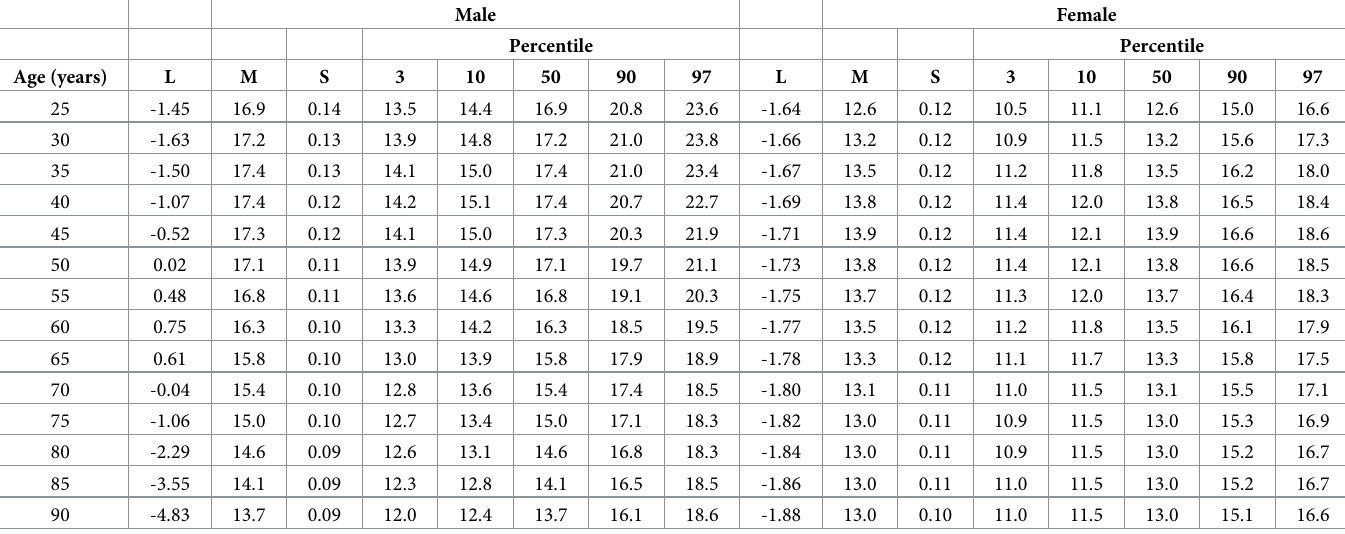
Table 3. Sex-specific percentile values for lean mass index (LMI) in individuals aged 21–90 years.